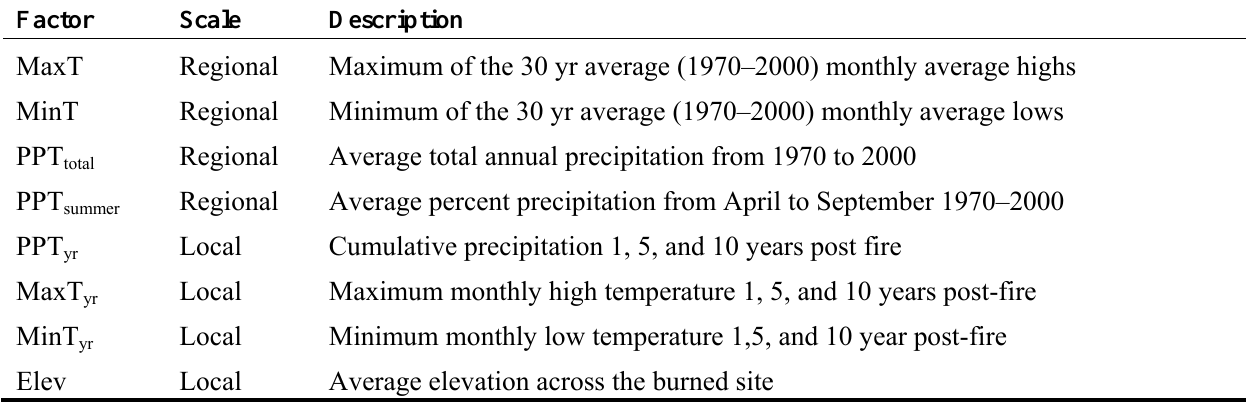
Table 2. Factors tested for their relationship with post-fire changes in NDVI and SD for fires across the western United States. Local scale precipitation and temperature data were summarized over one, five, and ten years, and thus three levels of each of these variables were